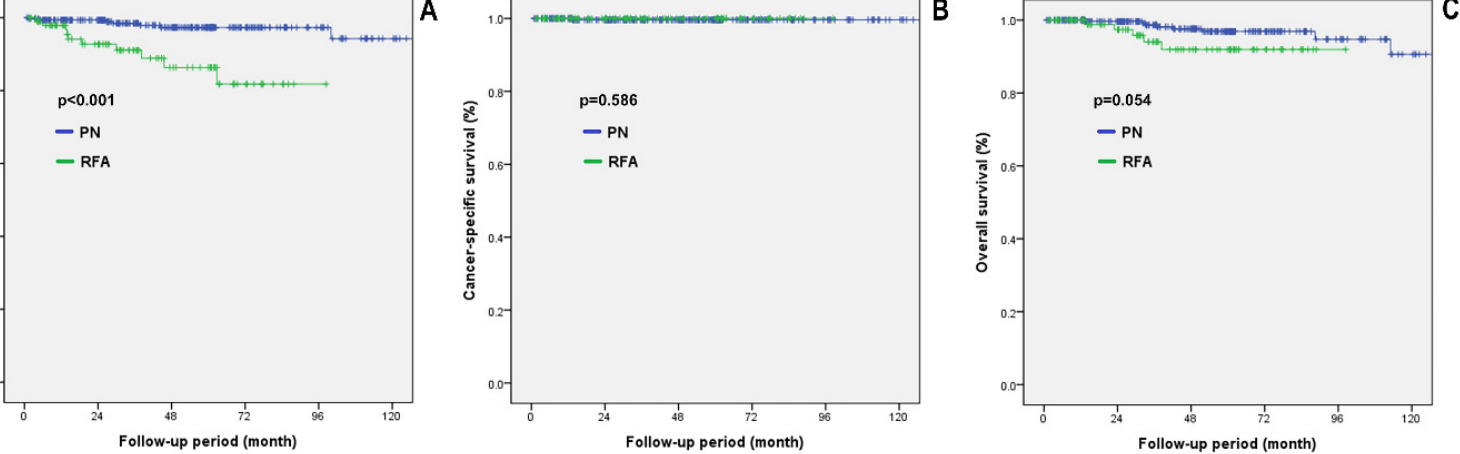
Figure 2. Survival analysis in propensity score matched cohorts. ( A ) RFS, Recurrence-free survival; ( B ) CSS, Cancer-specific survival; ( C ) OS, Overall survival; PN, Partial nephrectomy; RFA, Radiofrequency ablation.